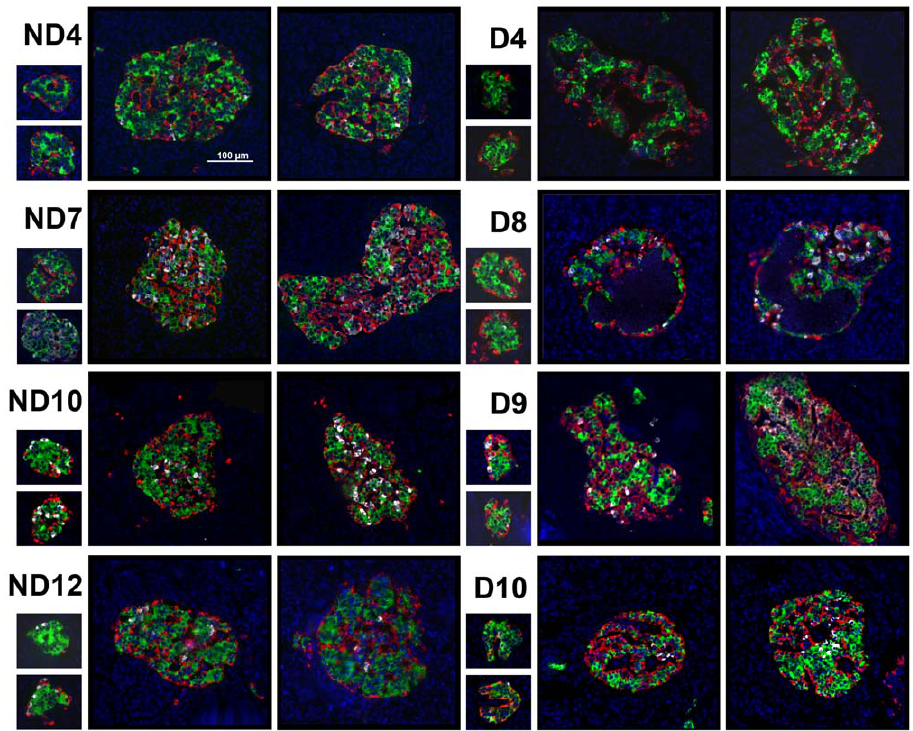
Figure 3. Morphology of randomly selected islets. ND4, ND7, ND10, ND12: specimen from non-diabetic subjects. D4, D8-D10: specimens from subjects with T2D. All listed by the ascending order of age in each group.